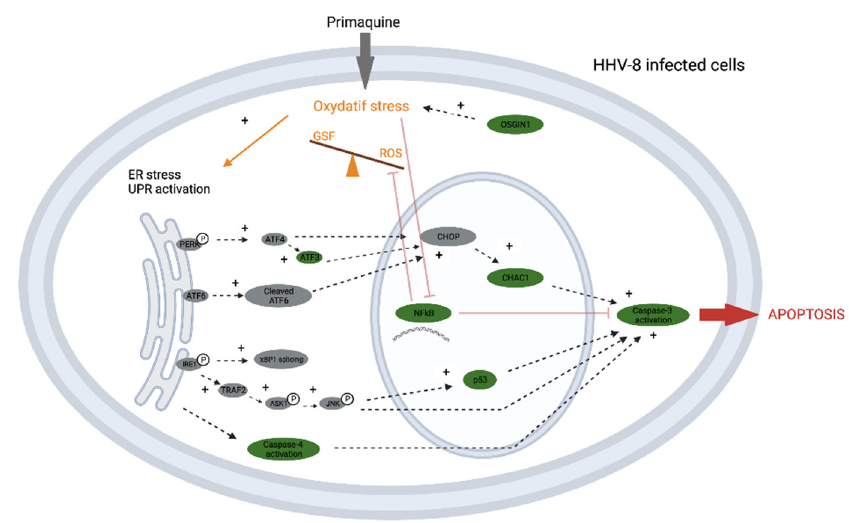
Figure 2. Schematic representation of primaquine action on KSHV-infected cells to induce apoptosis. Oxidative stress induced by the primaquine leads to an increase of ROS and decrease of the GSF. In response to the oxidative stress, the pro-apoptotic UPR pathway is activated and induced the up- regulation of the ATF3, CHAC-1 and OSGIN1 transcripts. Caspase-4 pathway could also be activated directly through the activation of the UPR pathway. The oxidative stress induced by primaquine could also inhibated the NFkB pathway, leading to the lifting of the negative retrocontrole on the expression of the caspase-3. Altogether, our result suggest that the primaquine could induced apoptosis on KSHV-infected cells by stimulating different pro-apoptotic pathways.